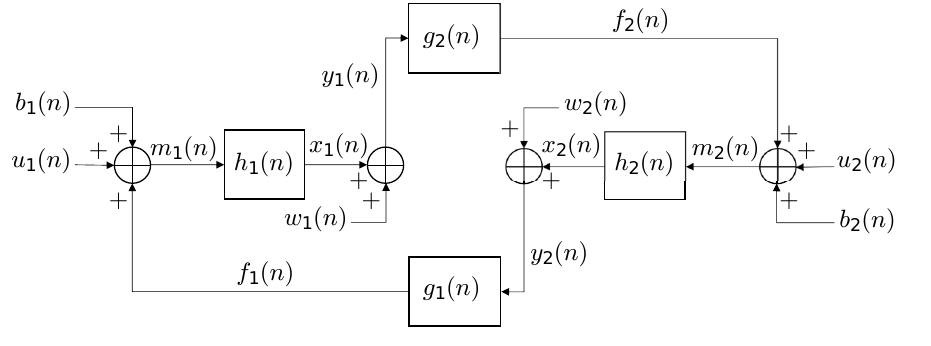
Figure A1. Two-room speech reinforcement system. The left-side system (the room of interest) includes the microphone signal m 1 ( n ) and the loudspeaker signal y 2 ( n ) . Correspondingly, the right- side system considers m 2 ( n ) and y 1 ( n )